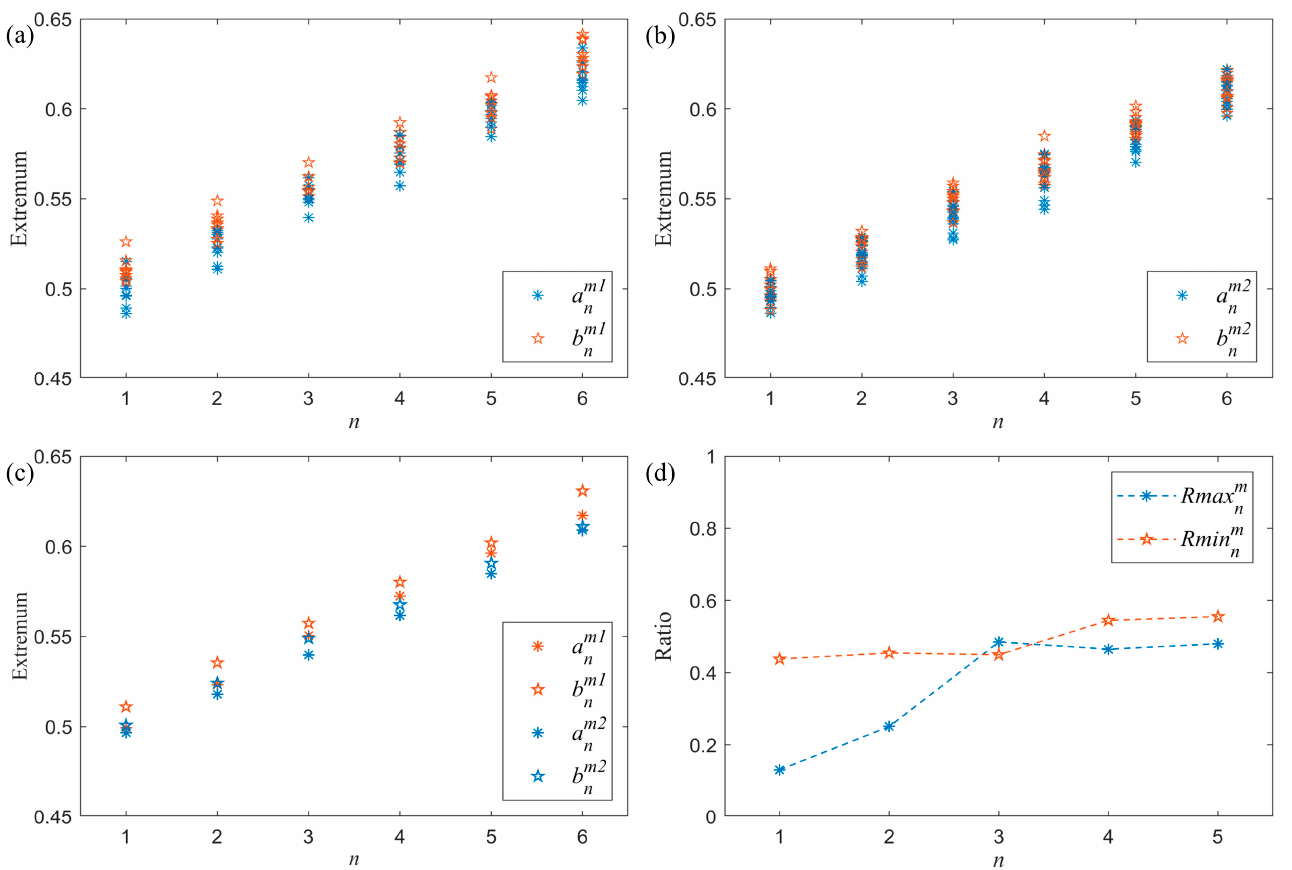
Figure 16. Measurement results of wavefront-division interference experiments at low signal-to-noise ratios. ( a ) extrema of the normalized interference term I ∆ of the coupler output 1; ( b ) extrema of the normalized interference term I ∆ of the coupler output 2; ( c ) average of the corresponding extrema of the normalized interference terms I ∆ of the two outputs; ( d ) Rmax m n and Rmin m n calculated from the extrema.